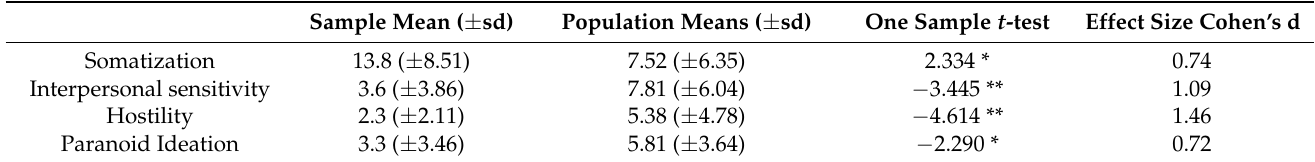
Table 2. One sample t-test for equality of SCL-90 mean values between HNS and general population.